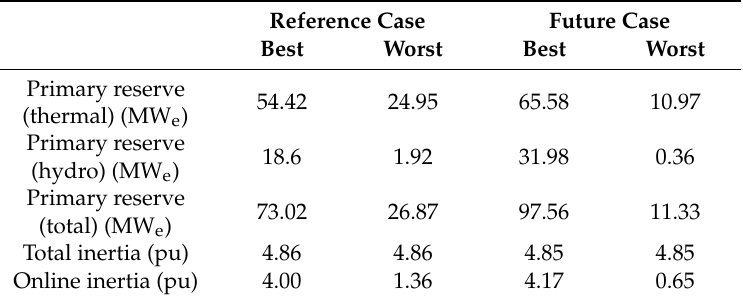
Table 5. Primary reserve and inertia for the reference and future